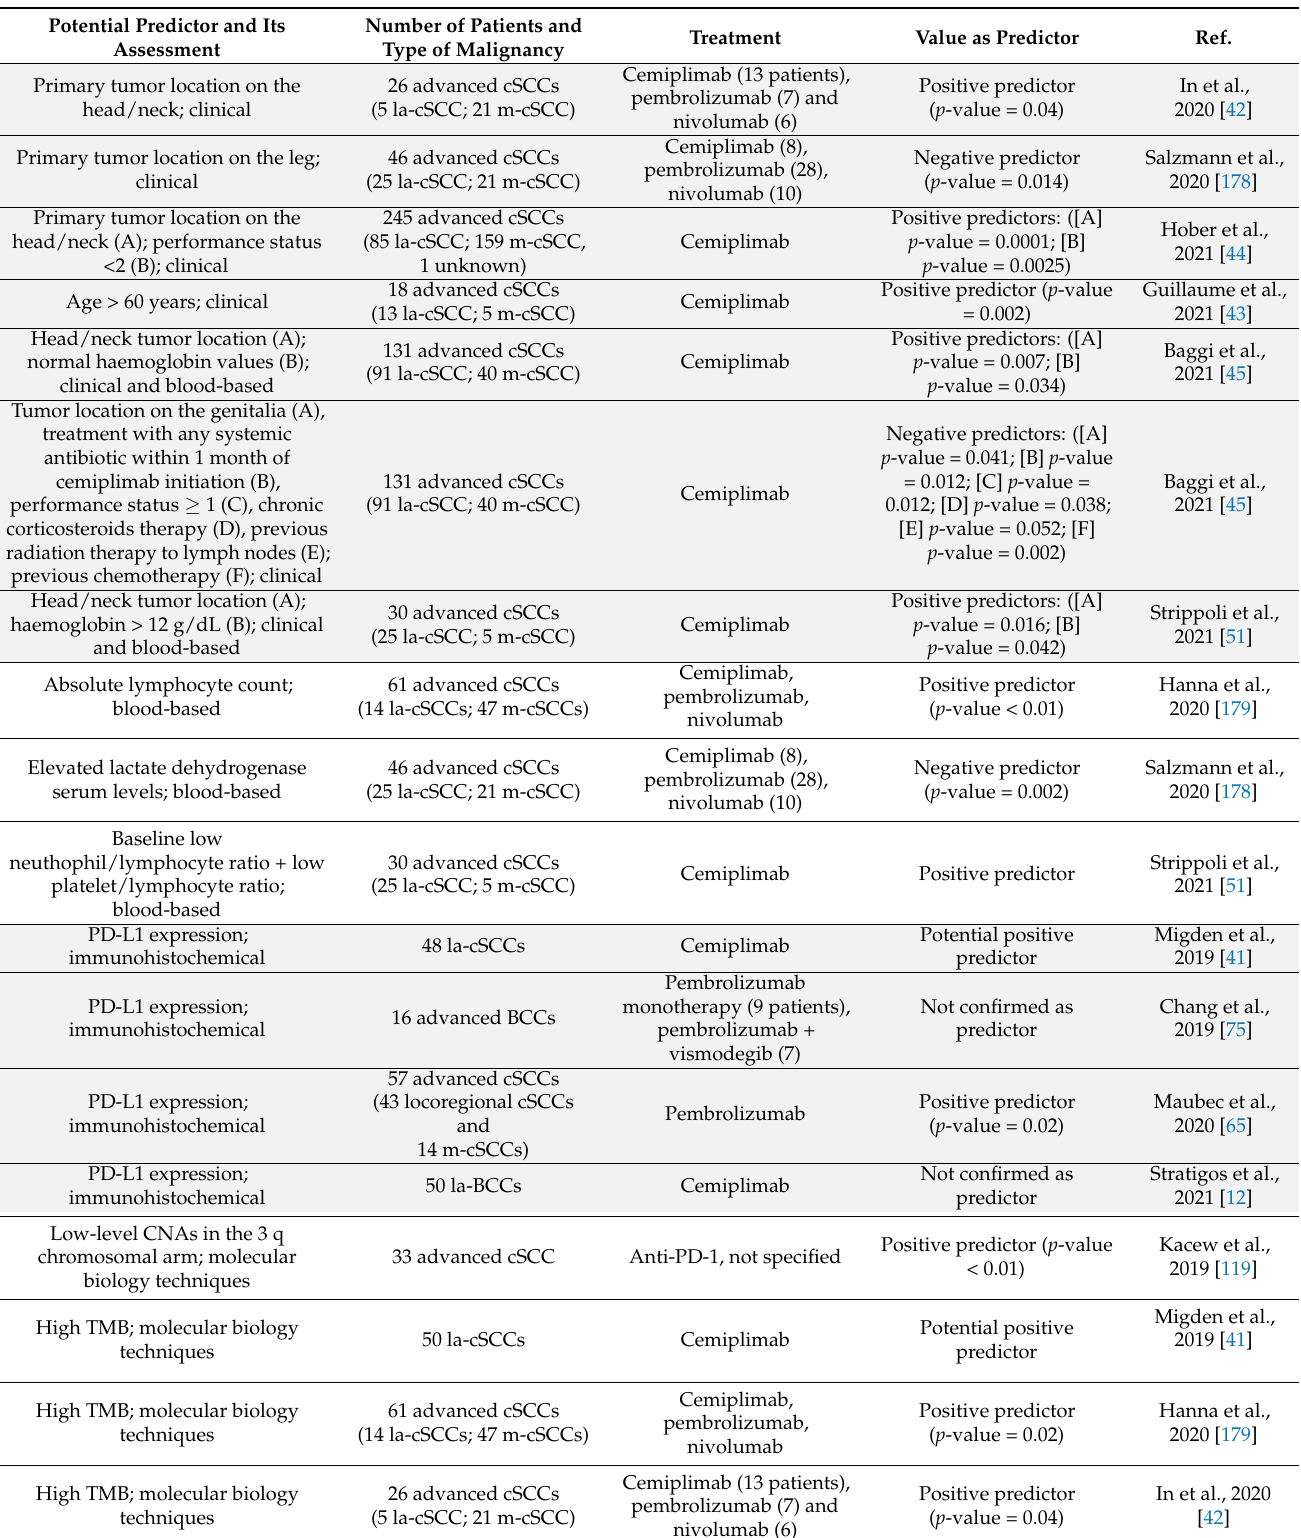
Table 7. Possible predictors to immune checkpoint inhibitors response in locally advanced and metastatic cutaneous squamous cell carcinoma and basal cell